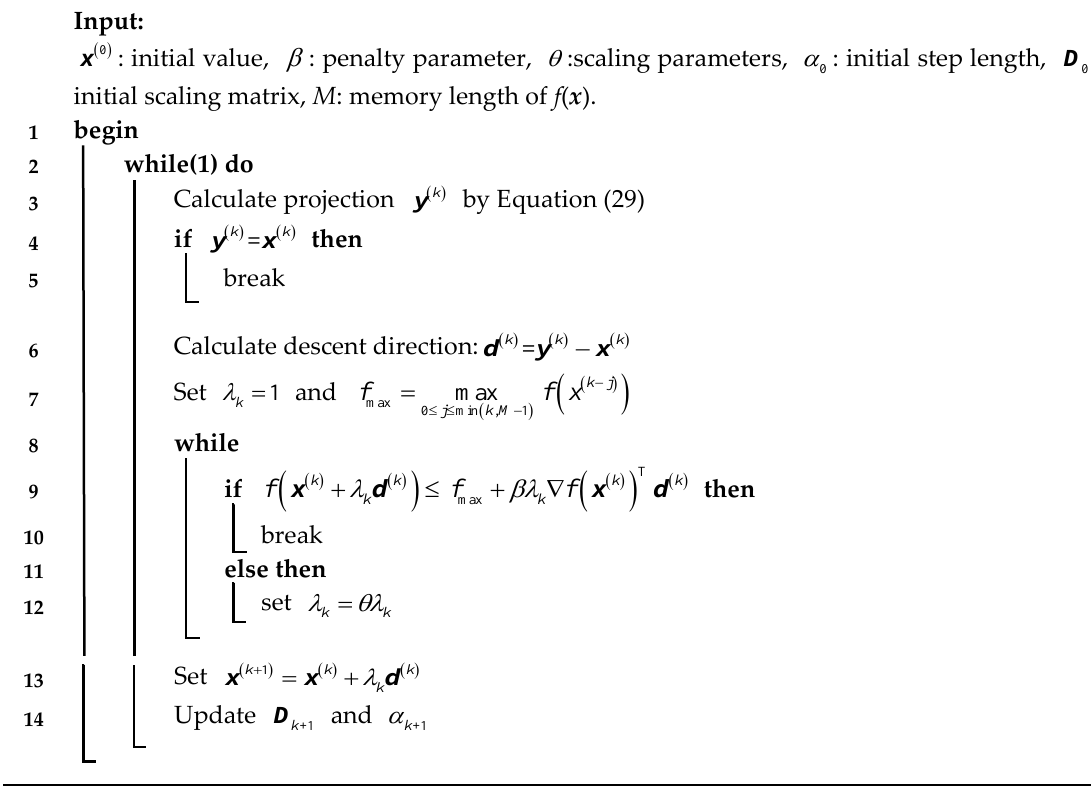
Algorithm 3: Image reconstruction by SGP